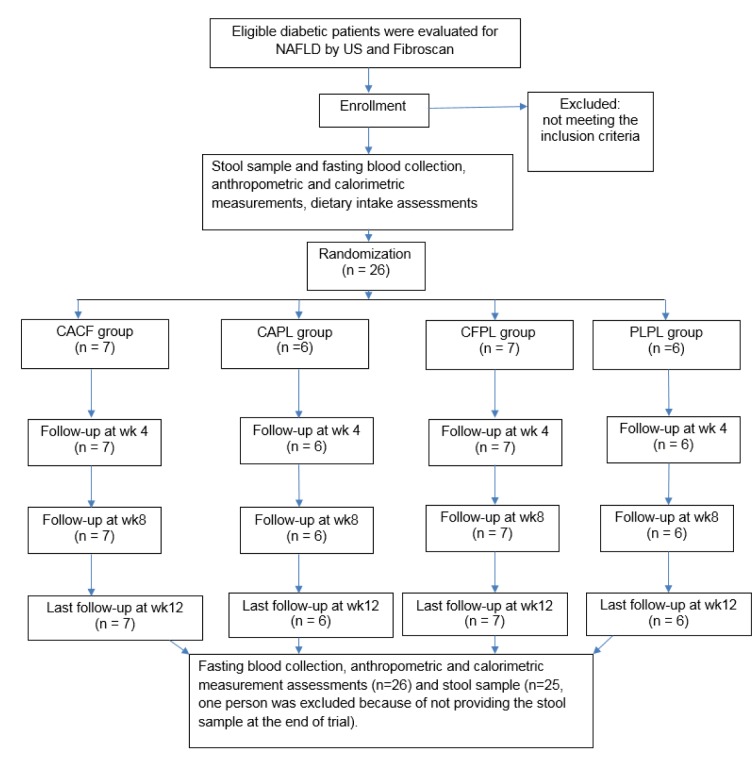
Study consort flow chartCF, Chlorogenic acid; CA, caffeine; PL, placebo